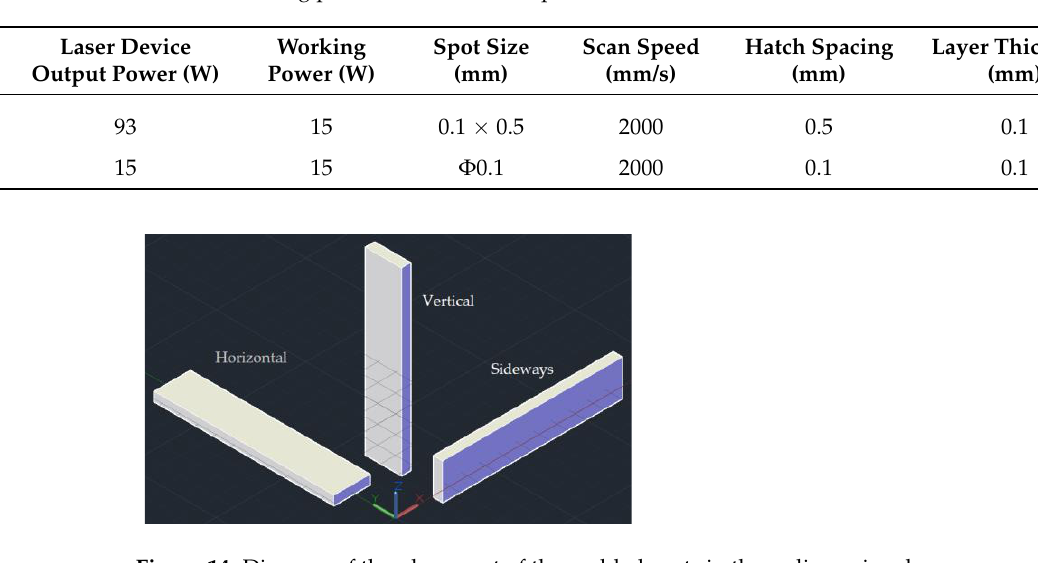
Table 7. Sintering parameters of molded parts.